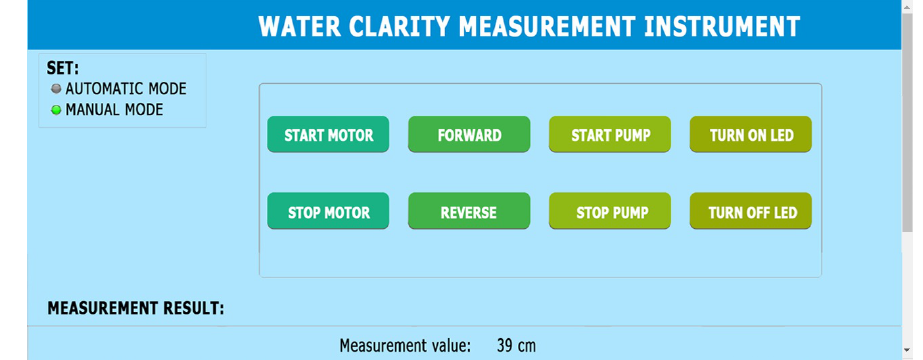
Figure 4. User interface for controlling the instrument from a computer via a WiFi modem.